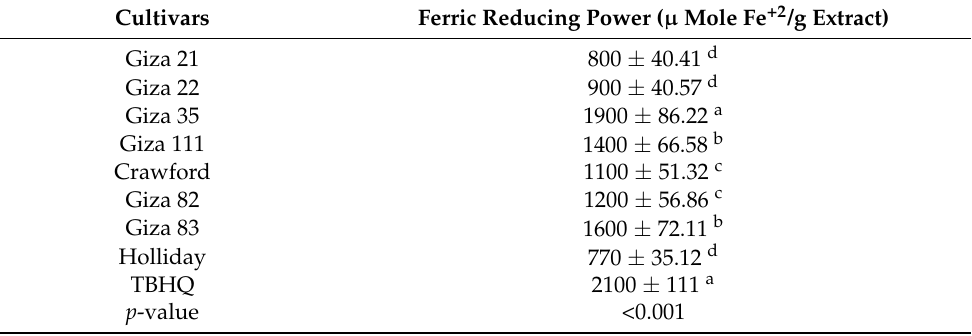
Table 5. The antioxidant activity of soybean cultivars methanolic extract at 800 µ g/mL determined as FRAP.